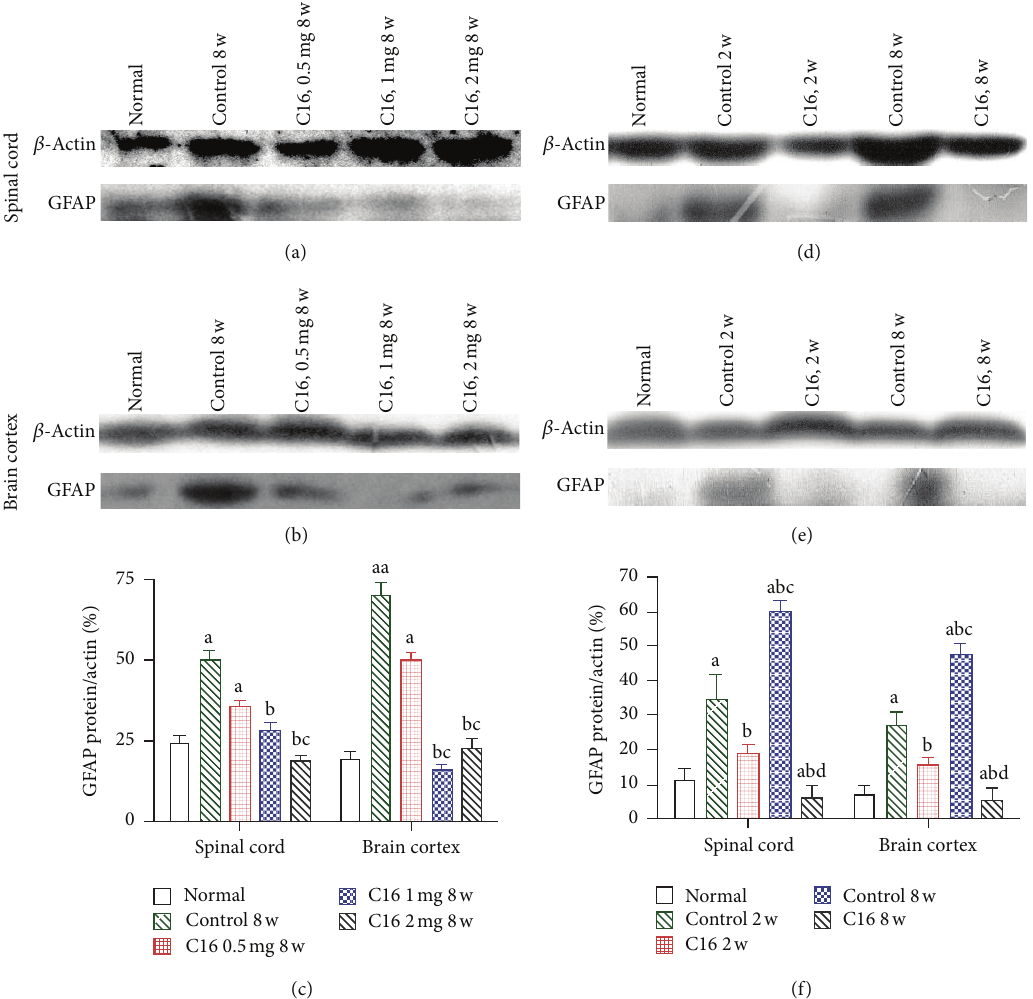
Figure 8: Medium and high-dose C16 treatment decreased evidently the expression levels of GFAP both in spinal cord (a) and cerebral cortex (b),showedbyWesternblottinganalysis.(c)ThelevelsofGFAPexpressionrevealedbyWesternblottinganalysisatweek8afterimmunization: aa 𝑃 < 0.01 versus normal rats, a 𝑃 < 0.05 versus normal rats, b 𝑃 < 0.05 versus vehicle control rats at week 8 postimmunization group, c 𝑃 < 0.05 versus 0.5 mg/per day C16 treated EAE rats at week 8 after immunization. The levels of GFAP expression were declined remarkably by late C16 application both in spinal cord (d) and cerebral cortex (e) compared with the vehicle control. (f) The levels of GFAP expression revealed by Western blotting analysis: a 𝑃 < 0.05 versus normal rats, b 𝑃 < 0.05 versus vehicle control rats, c 𝑃 < 0.05 versus C16 treated EAE rats at week 2 postimmunization group and d 𝑃 < 0.05 versus vehicle control rats at week 8 after